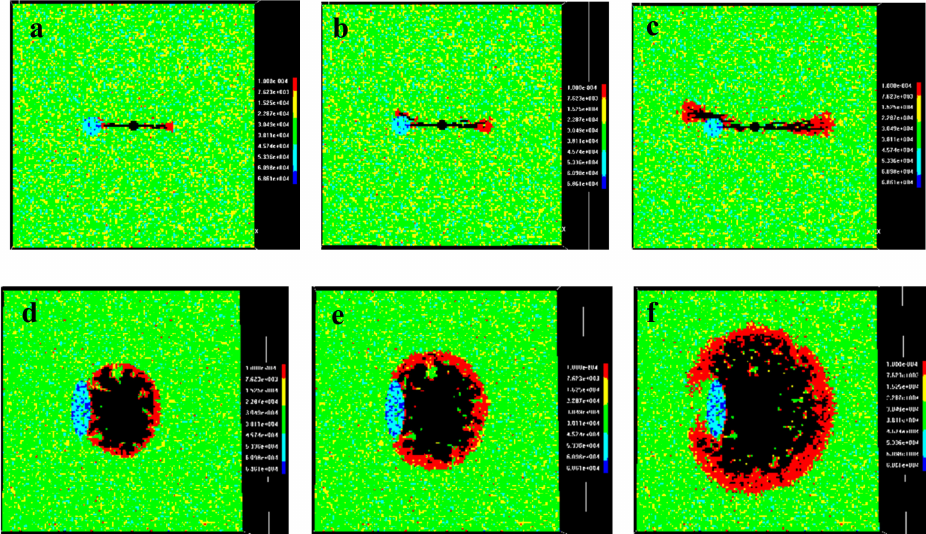
Figure 18. HF geometries during the fracturing process in Case G. ( a – c ) show the HF geometries during fracturing in the horizontal cross-section; ( d – f ) show the corresponding HF geometries in the vertical